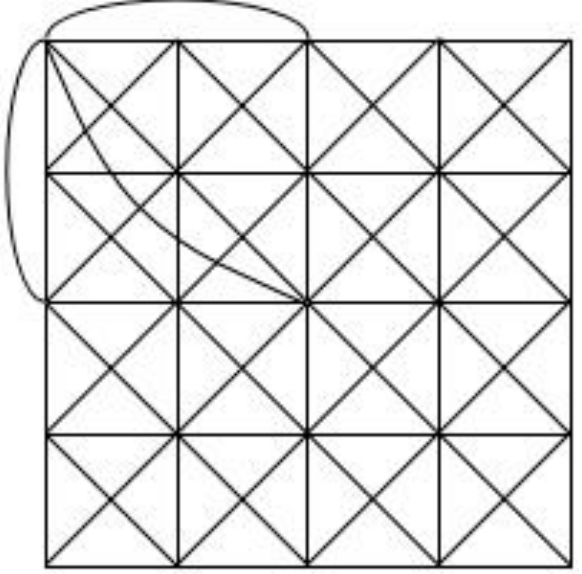
Figure 2. Schematic diagram of an anisotropic optimization topology.